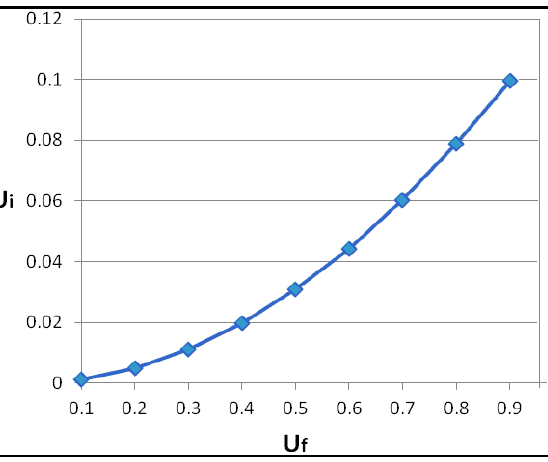
Figure 9. Interphase content versus filler content.